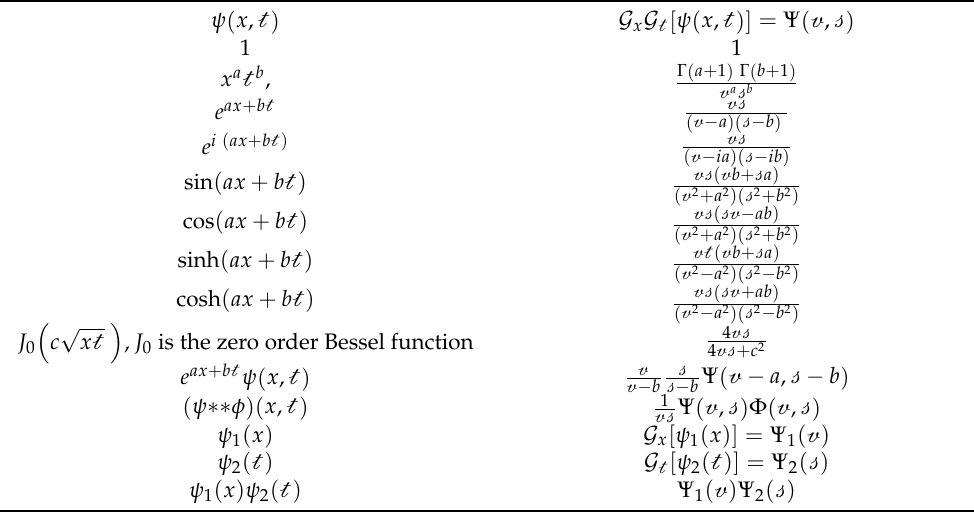
Table 2. DARAT for some elementary